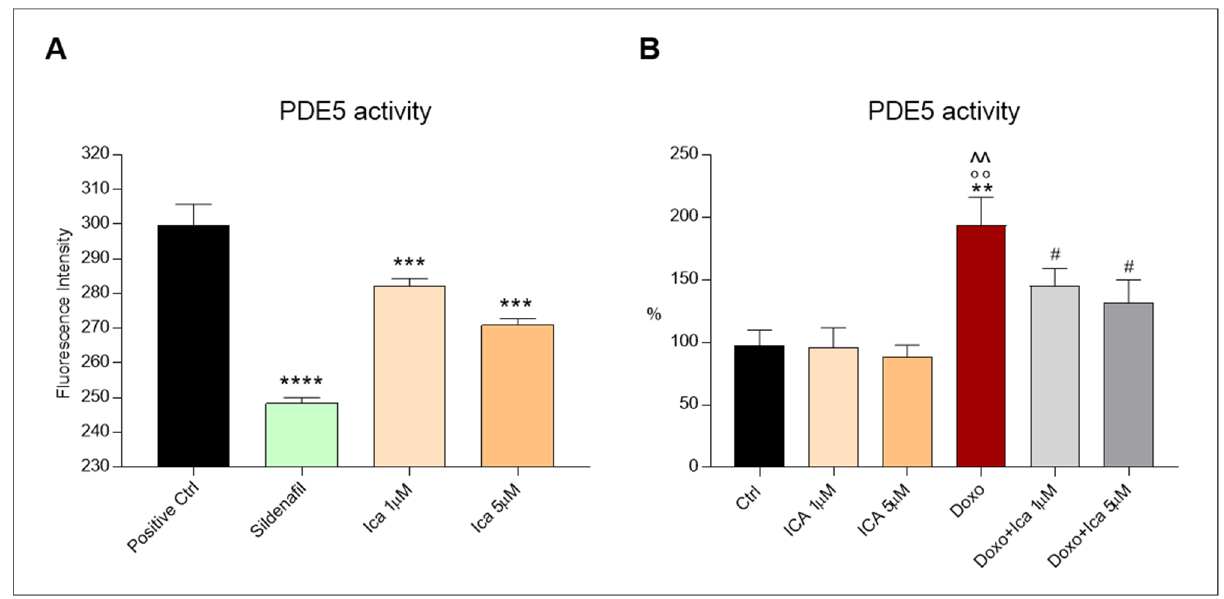
Figure 8. The inhibitory effect of Ica on phosphodiesterase-5a activity. ( A ). Treatment with Ica 1 μ M resulted in a reduction of phosphodiesterase-5a (PDE5a) activity, while sildenafil and Ica 5 μ M significantly reduced PDE5a activity. ( B ). On H9c2 cells, the increased activity of PDE5a, determined by Doxo, was significantly reduced by ICA1 μ M and by ICA5 μ M. Data are expressed as mean ± S.E.M. ** p < 0.01 vs. Ctrl; *** p < 0.001 vs. Positive Ctrl; **** p < 0.0001 vs. Positive Ctrl; °° p < 0.01 vs. Ica 1 μ M; ^^ p < 0.01 vs. Ica 5 μ M; # p < 0.05 vs. Doxo; Tukey’s multiple comparisons test and Mann Whitney test ( n = 3). Data is for three independent